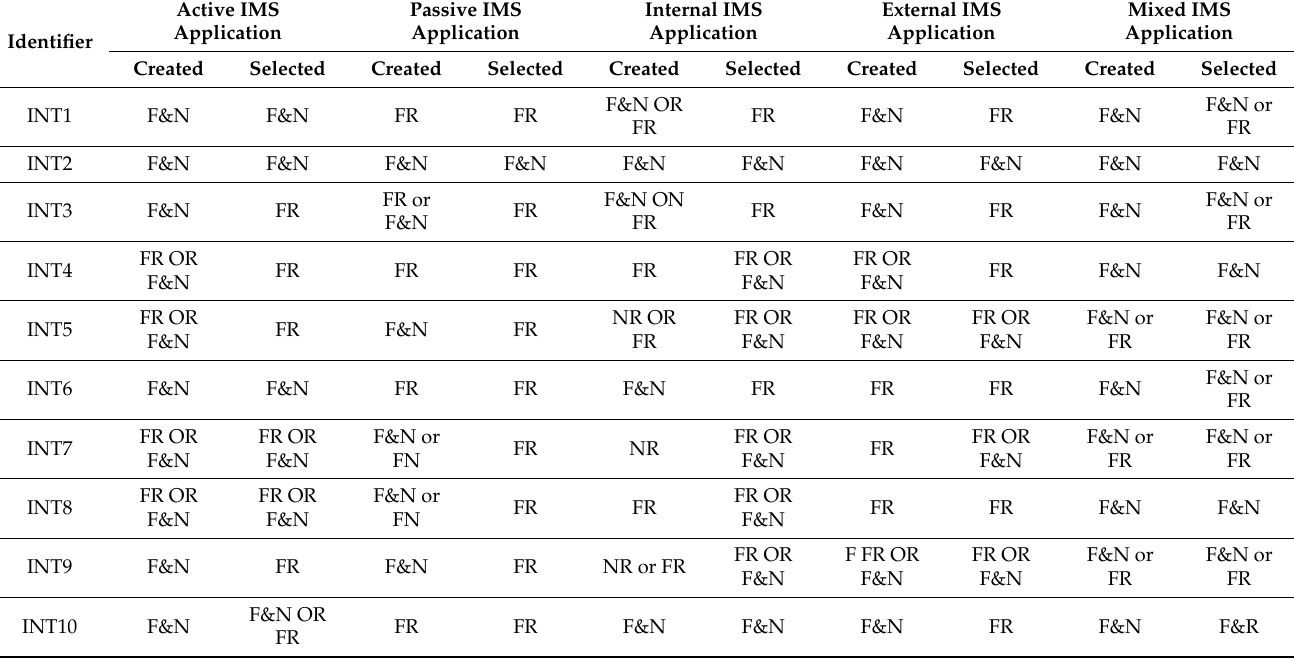
Table 13. Summary of interview